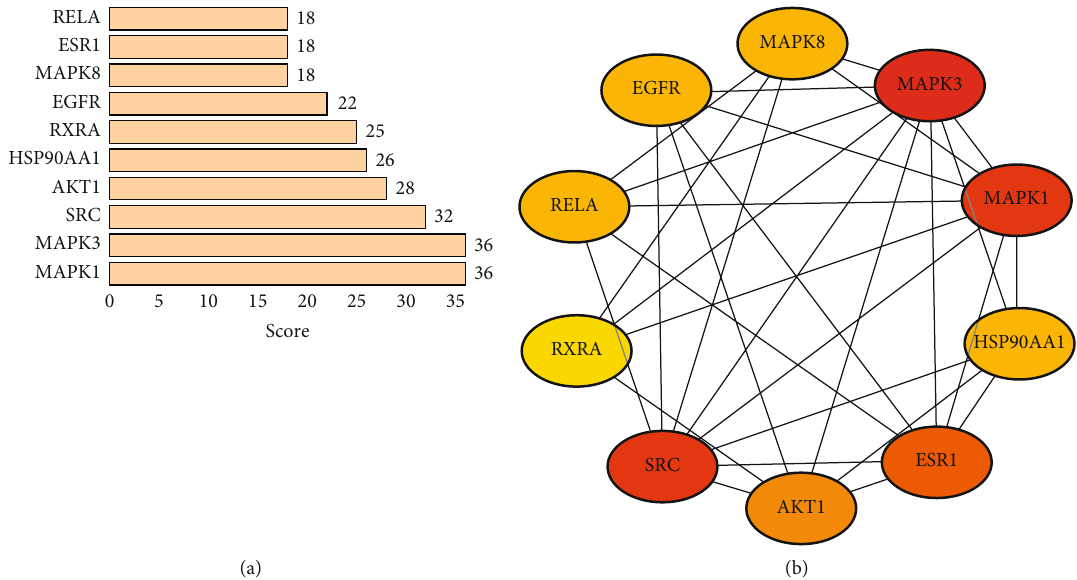
Figure 4: (a) The top 10 e ff ective targets were ranked by degree value. (b) The color based on the degree of connectivity of the